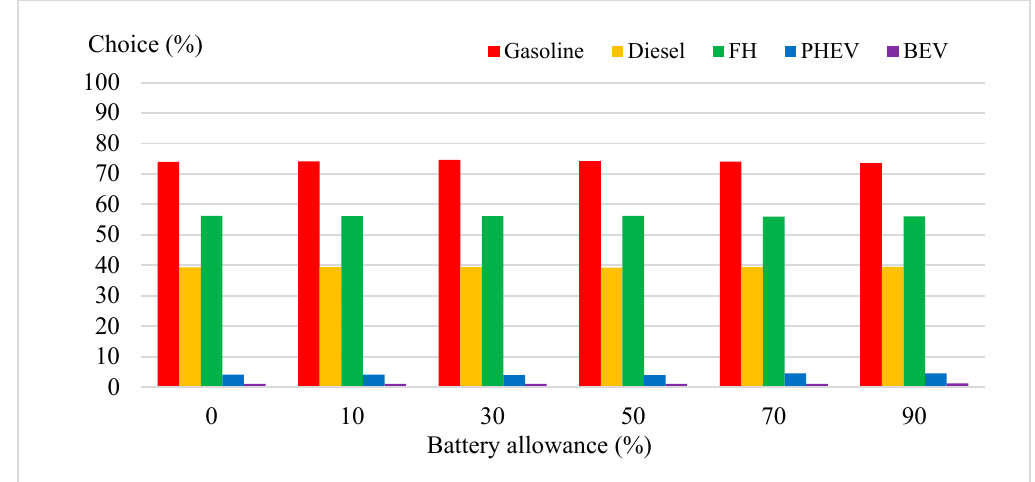
Figure A3. Market simulation results (Scenario B: German energy mix).